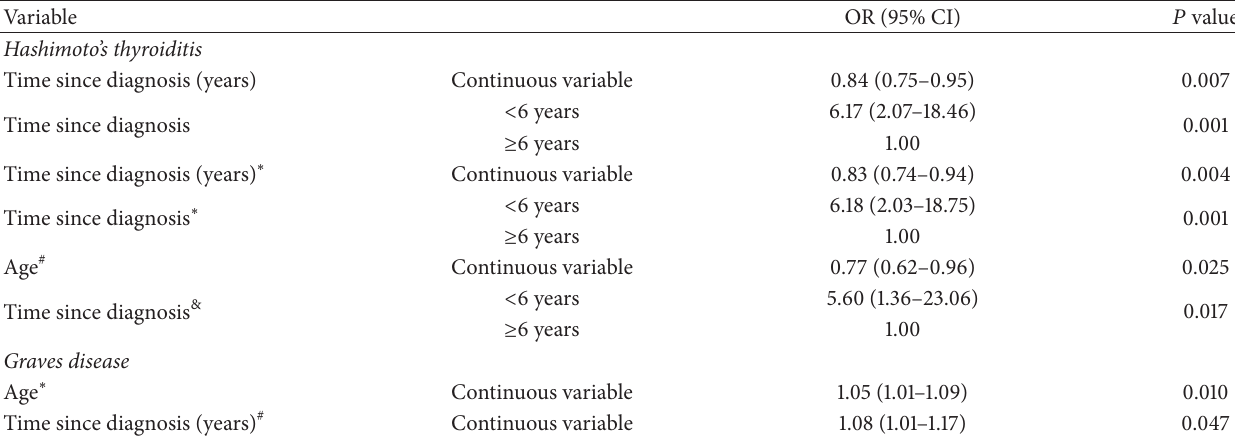
Table 4: Factors associated with infertility in women with GD and HT, in the whole sample and the subgroups of age ≤ 35 years and > 35 years, following multivariate logistic regression